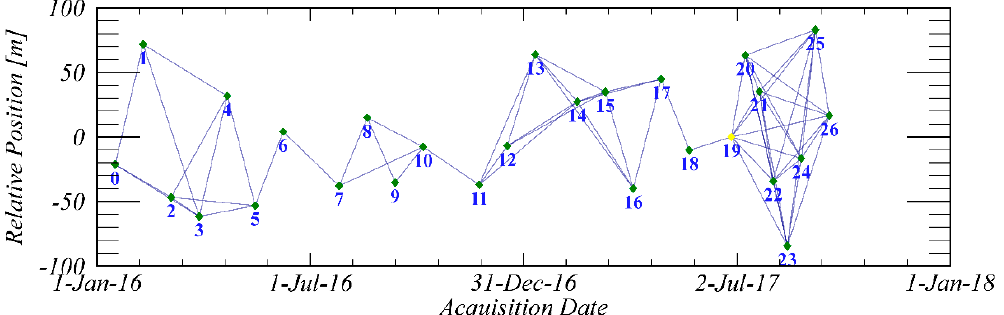
Figure 2. Spatial temporal baselines for the interferograms. Points represent SAR frames listed in Table S1 and numbered lines are the interferometric pairs.